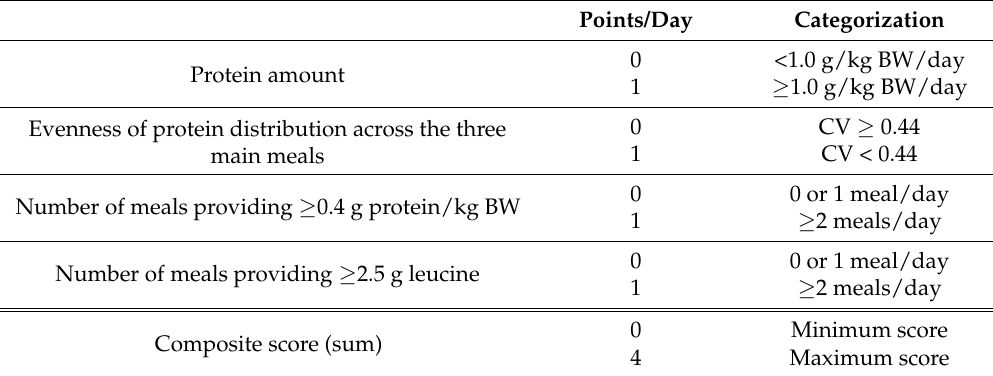
Table 1. Categorization of the protein intake composite